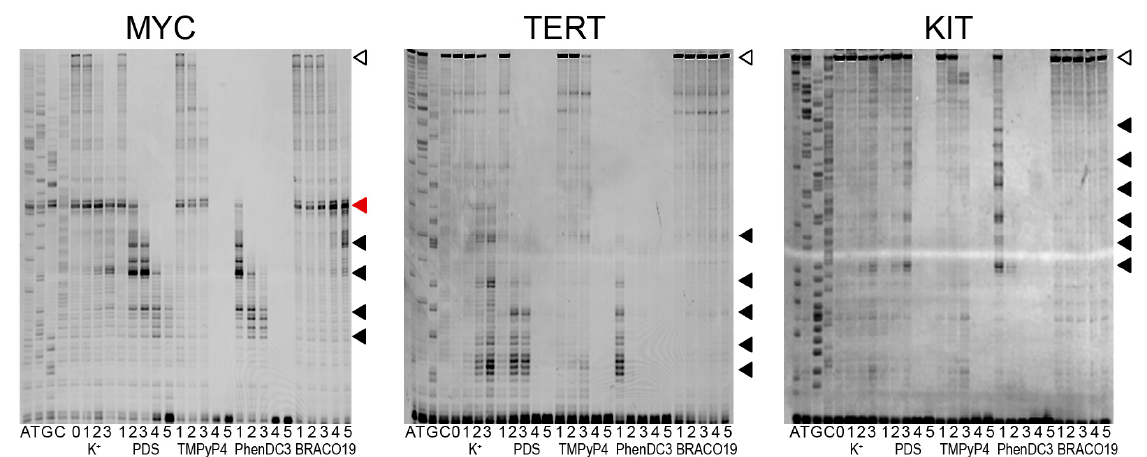
Figure 2. Products of elongation of a FAM-labeled primer on quadruplex sequences in the promoter regions of human genes ( MYC , KIT and TERT ) in the presence of PDS, TMPyP4, PhenDC3, BRACO-19, and potassium ions in different concentrations. The profile was obtained in a denaturing 10% PAAG. Lanes 0–3 for K + corresponds to potassium concentration of 0, 1, 5, 10 mM in the primer extension reaction. Lanes 1–5 for compounds are for concentrations 0.1, 0.5, 1, 5, 10 µM, respectively. Polymerase pauses were marked by black-filled triangles. The red triangle indicates a non-G4 type of polymerase pausing. The open triangle is a full-length product.